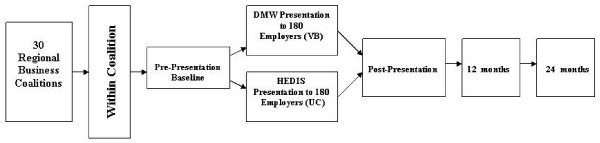
Research Design.